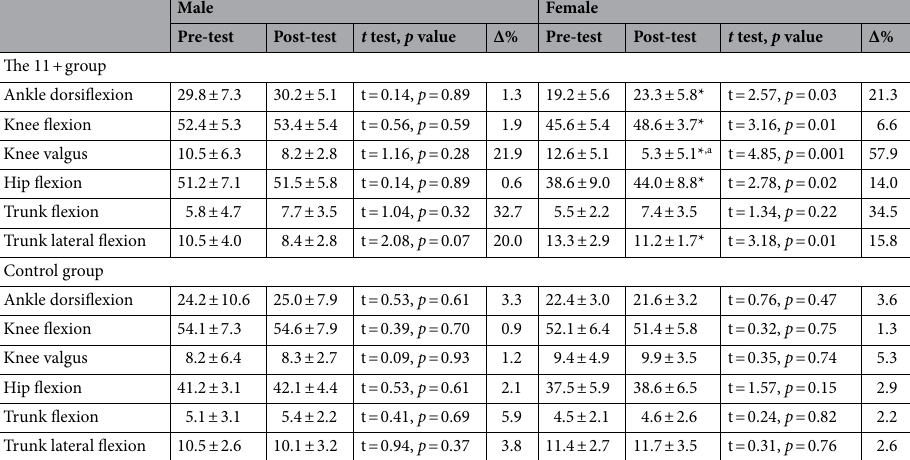
Table 1. Kinematic variables (degrees) (values are mean ± SD ), and percentage of change (∆%) (values are (post-test-pre-test/pre-test) × 100). SD standard deviation, t test paired sample t test. *Significant differences between pre-test and